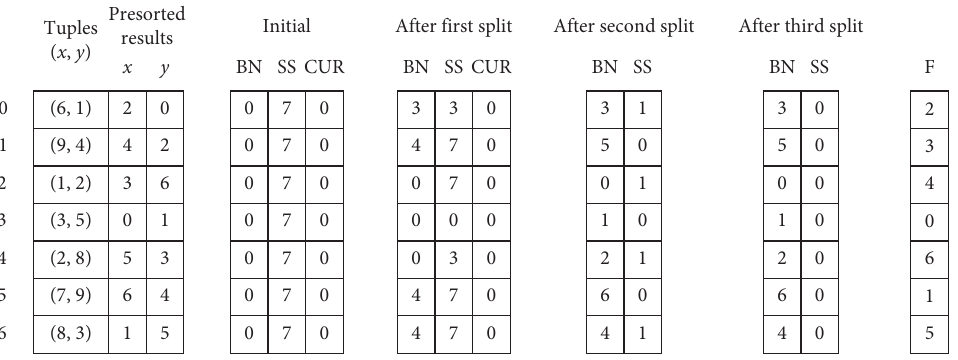
Figure 1: An example to construct the KD tree based on the new